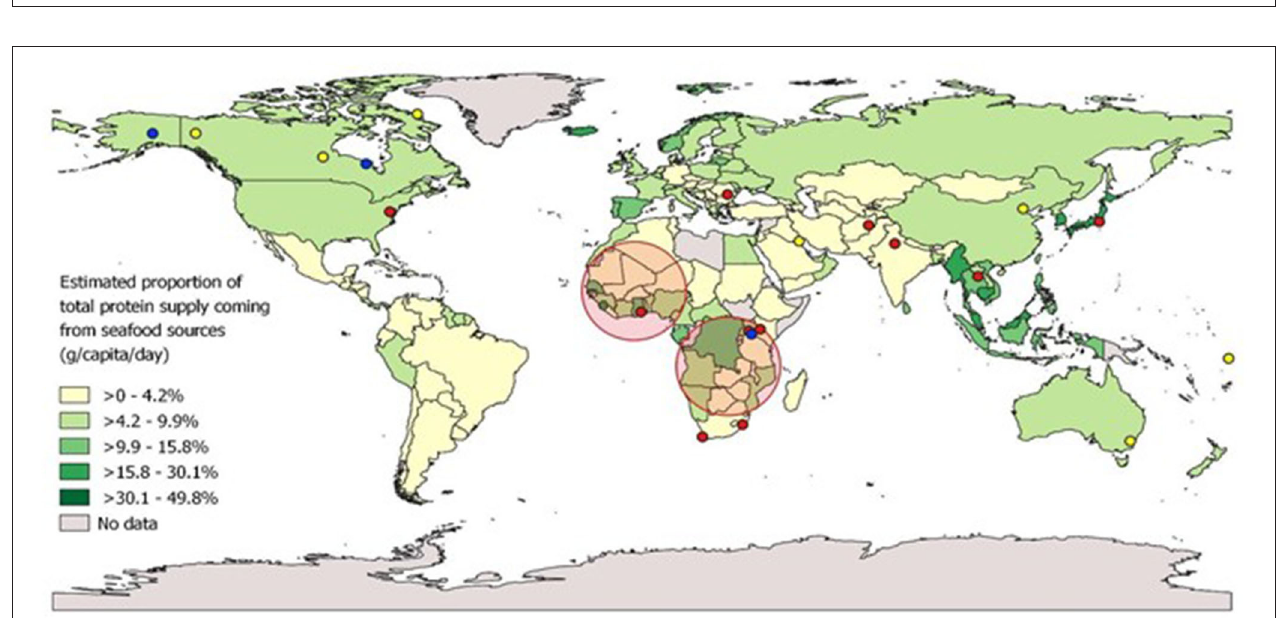
FIGURE 5 | Geographic distribution of papers reviewed in-depth. Papers with a global scope are not represented. Where papers focused on an entire country, their geographic location is given as the capital city. Two papers considered multi-country regions—these are indicated by the two large circles (these circles do not delineate the exact area covered), one of which was relating to West Africa, and one relating to Sub-Saharan Africa. Colors show how integral seafood was to this paper—blue dots indicate seafood was very integral, yellow that seafood was moderately integral, and red that seafood was not very integral. Green country shading indicates the estimated proportion of total protein supply derived from seafood (calculated as the sum of total fish and total other aquatic protein supply) in 2013, as per FAOSTAT food balance sheet data (FAO, 2017). The map was prepared in QGIS and values were categorized using Jenks natural breaks classification to show groups in the